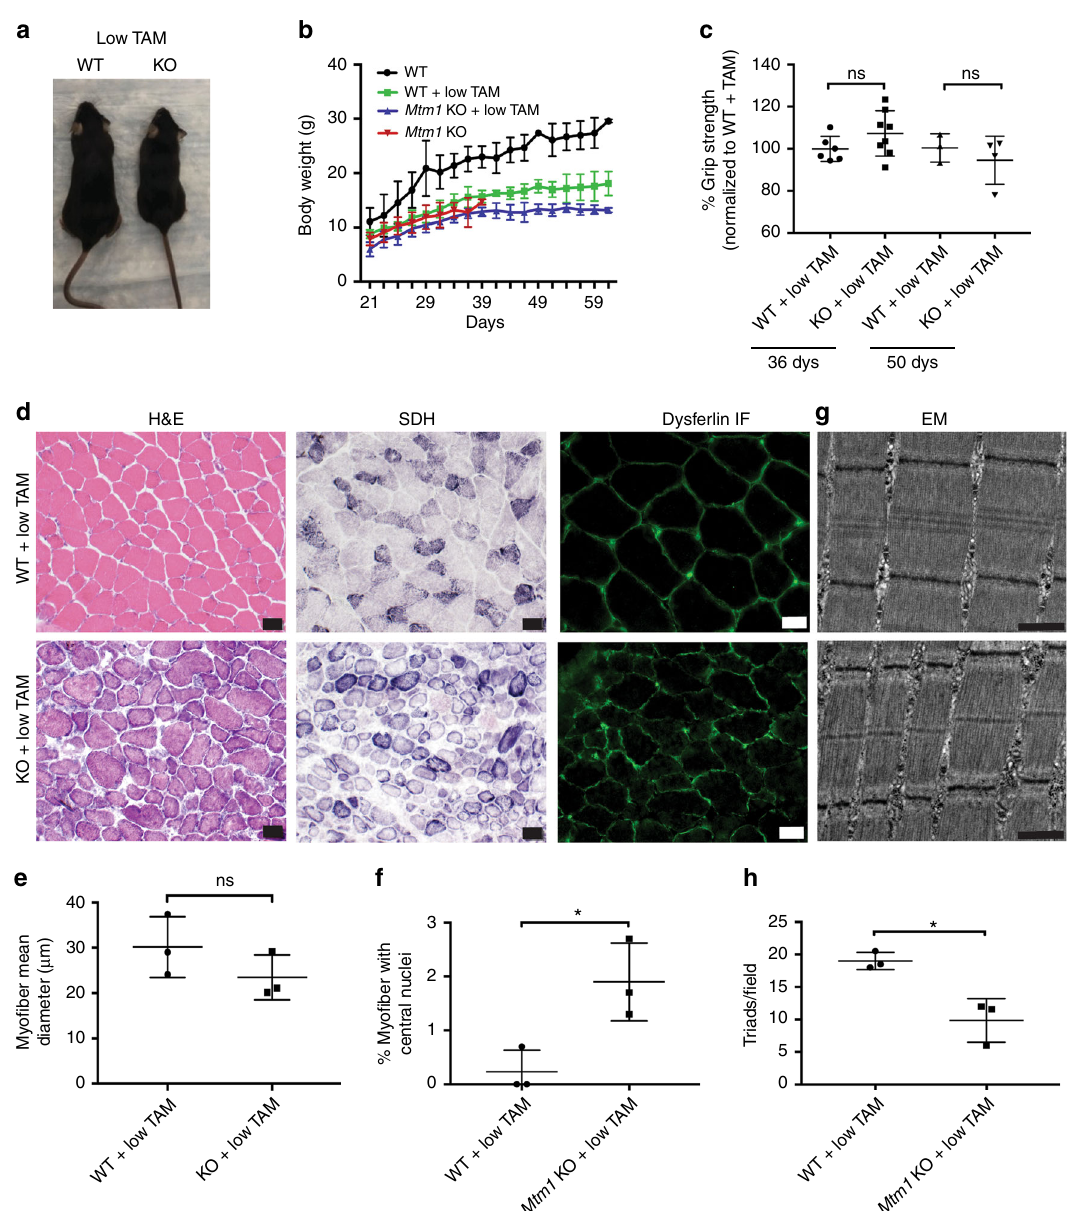
Fig. 3 Early low-dose tamoxifen treatment prolongs survival and improves muscle strength and structure of Mtm1 KO mice. a Photomicrograph of littermates at 28 days of WT, and Mtm1 KO treated with low-dose tamoxifen starting 14 days of age. KO treated with low-dose tamoxifen have normal hindlimb positioning and appear similar in size to WT littermates. b Plots of body weight show that low-dose treated KOs ( n = 5) starting at 14 days have similar weight as compared to low-dose treated WT ( n = 3) and untreated KOs. c Early TAM treated KOs have improvement in muscle strength when analyzed at 36 and 50 days of age. At 36 days, TAM treated KOs ( n = 8) have a mean grip strength of 107 ± 4% vs. TAM treated WT of 100 ± 2% ( n = 6, p -value non-signi fi cant). At 50 days, TAM treated KOs ( n = 4) have a mean grip strength of 95 ± 6% vs. TAM treated WT of 100 ± 4% ( n = 3, p -value non-signi fi cant). Data normalized to the mean grip strength of WT + TAM littermates. d Early TAM treatment restores Mtm1 KO muscle structure. Cross- sections from tibialis anterior muscle tissue taken at 36 days and stained for H&E, SDH, and dysferlin (scale bars 20 μ m). Early TAM treatment improves overall appearance and myo fi ber size but not % central nuclei. e Myo fi ber size for KO + TAM = 24 ± 3 μ m ( n = 3) vs. WT + TAM = 30 ± 4 μ m ( n = 3, p non-signi fi cant). f Average percent of central nuclei (per 100 fi bers) in KO + low-dose TAM = 2 ± 0.4% vs. WT + low-dose TAM = 0.2 ± 0.1% ( n = 3, *p = 0.03). g Electron microscopy reveals increased triad number in early treated Mtm1 KOs vs. untreated KOs (scale bars 500 nm). However, triad number is decreases as compared to early treated WT. h Quanti fi cation of number of triads per fi eld for WT + low-TAM = 19 ± 1.0 ( n = 3) vs. KO + low TAM = 10 ± 2.0 ( n = 3, * p < 0.02 compared to WT + TAM). For reference, untreated Mtm1 KOs have 5 ± 1.5 ( n = 5) (Fig.